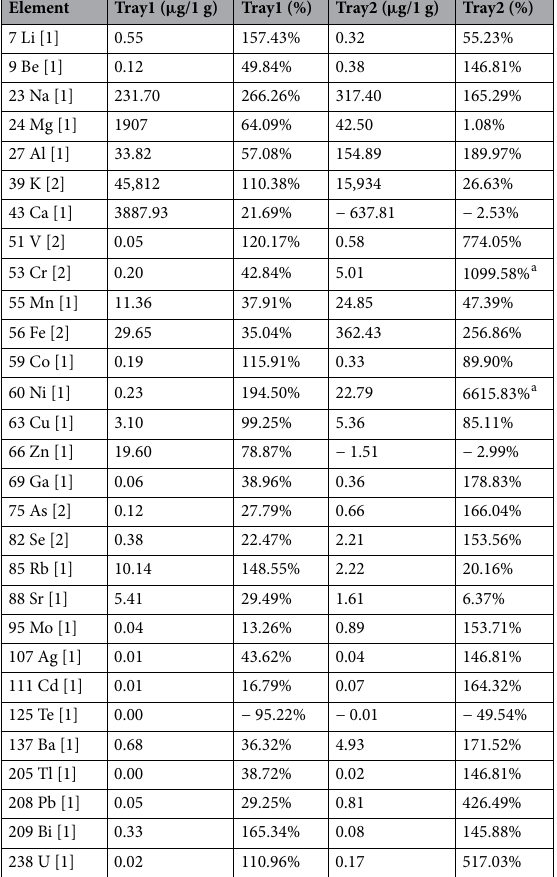
Table 5. Average elements content increase ( µ g/g and relative %) between mechanically induced plants and their control group in each tray.